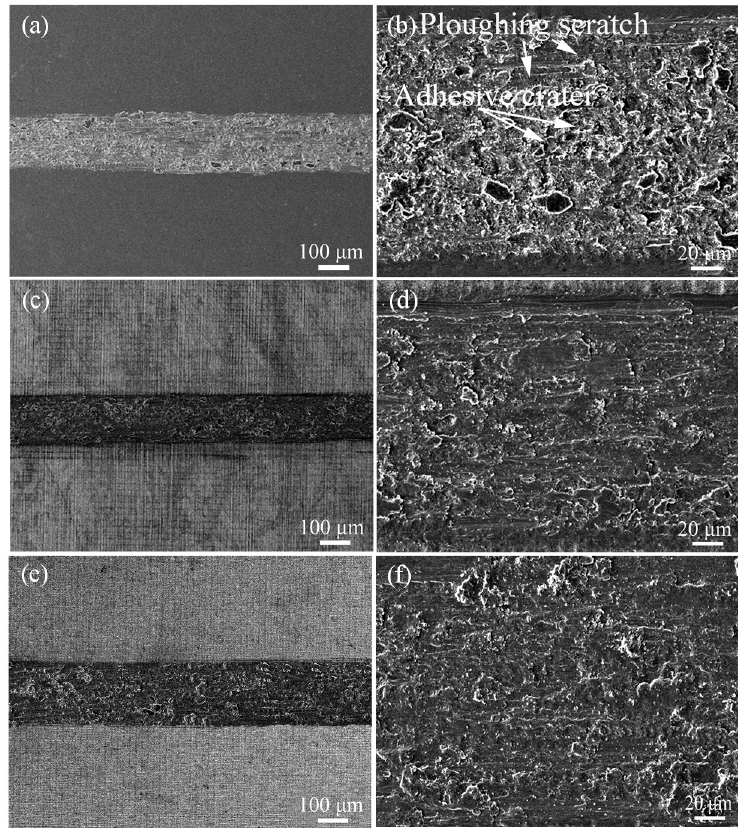
Figure 7. SEM micrographs of the wear tracks under starved oil lubricated conditions. ( a , b ) Wear tracks of SS; ( c , d ) Wear tracks of LIPSS-90; ( e , f ) Wear tracks of LIPSS-0.